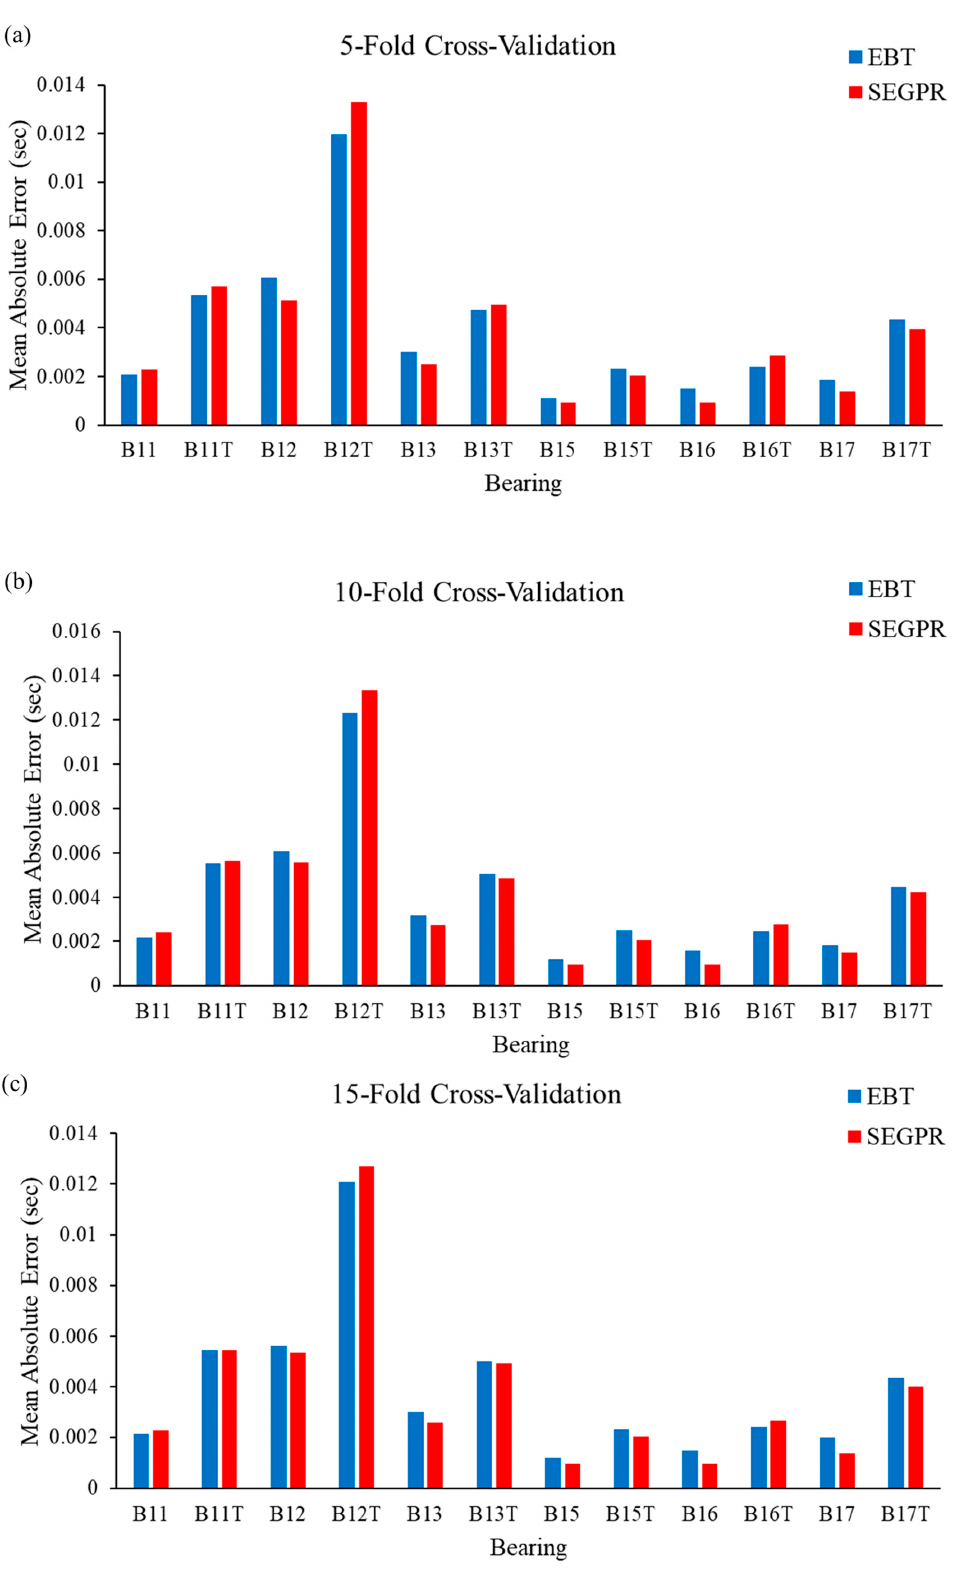
Figure 10. ( a – c ). MAE values observed from the EBT and SEGPR ML models. Table 4. A comparative study between current work and previously published papers to predict bearing degradation using different ML models.